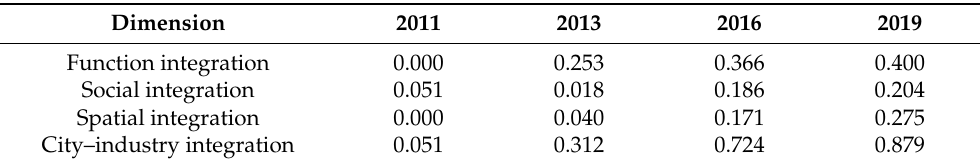
Table 10. Evaluation results for the city–industry integrated development of the Kangqiao indus- trial park.